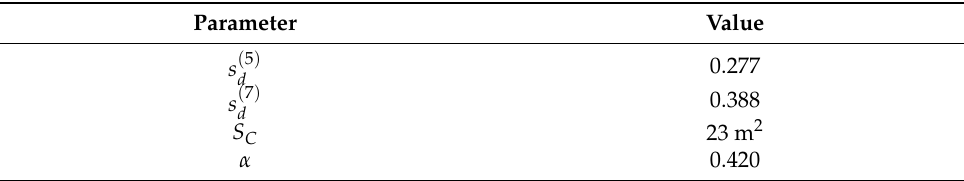
Figure 13. Apparent variation of ingested mass flow rate, indicated as Δ𝑚(cid:4662) ((cid:3028)(cid:3043)(cid:3043)) (cid:2875)(cid:2879)(cid:2873) calculated from the thrust variations and comparison with the background flow model (with an amplitication factor β = 49.6) for HT20k L. Table 3. Background flow model and summary of the used parameters.